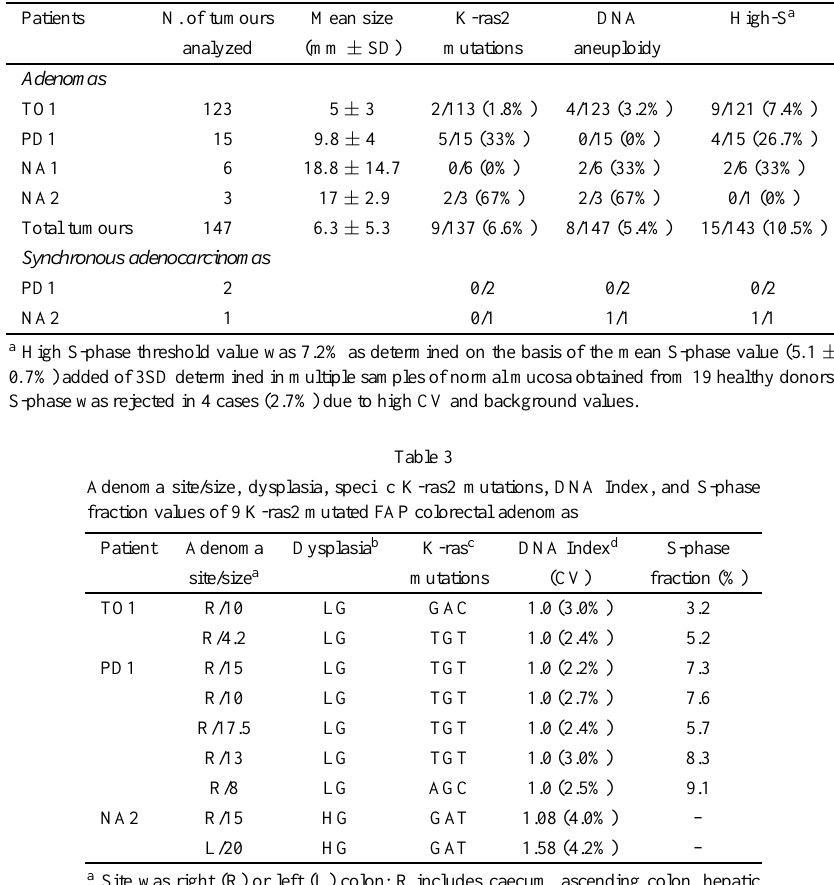
a Site was right (R) or left (L) colon: R includes caecum, ascending colon, hepatic flexure, transverse colon; L includes splenic flexure, descending colon, sigmoid colon and rectum. Size was indicated by approximate diameter in mm.